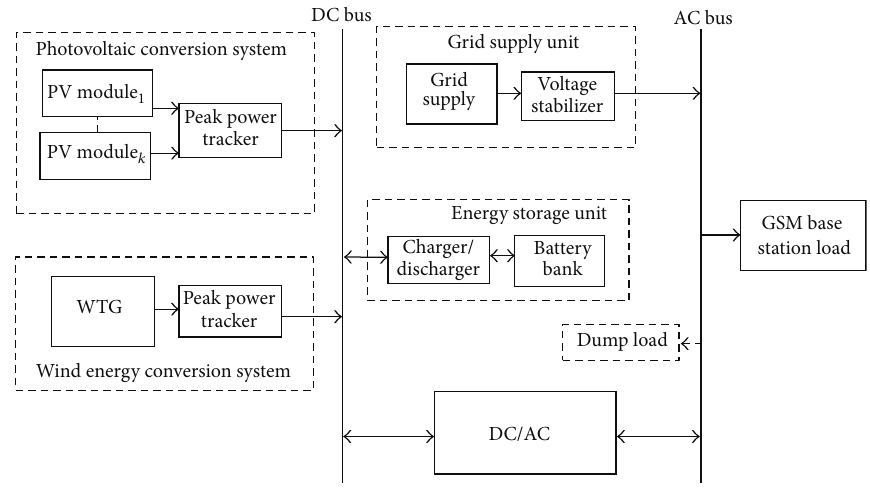
Figure 3: Block diagram of the proposed system structure for electricity